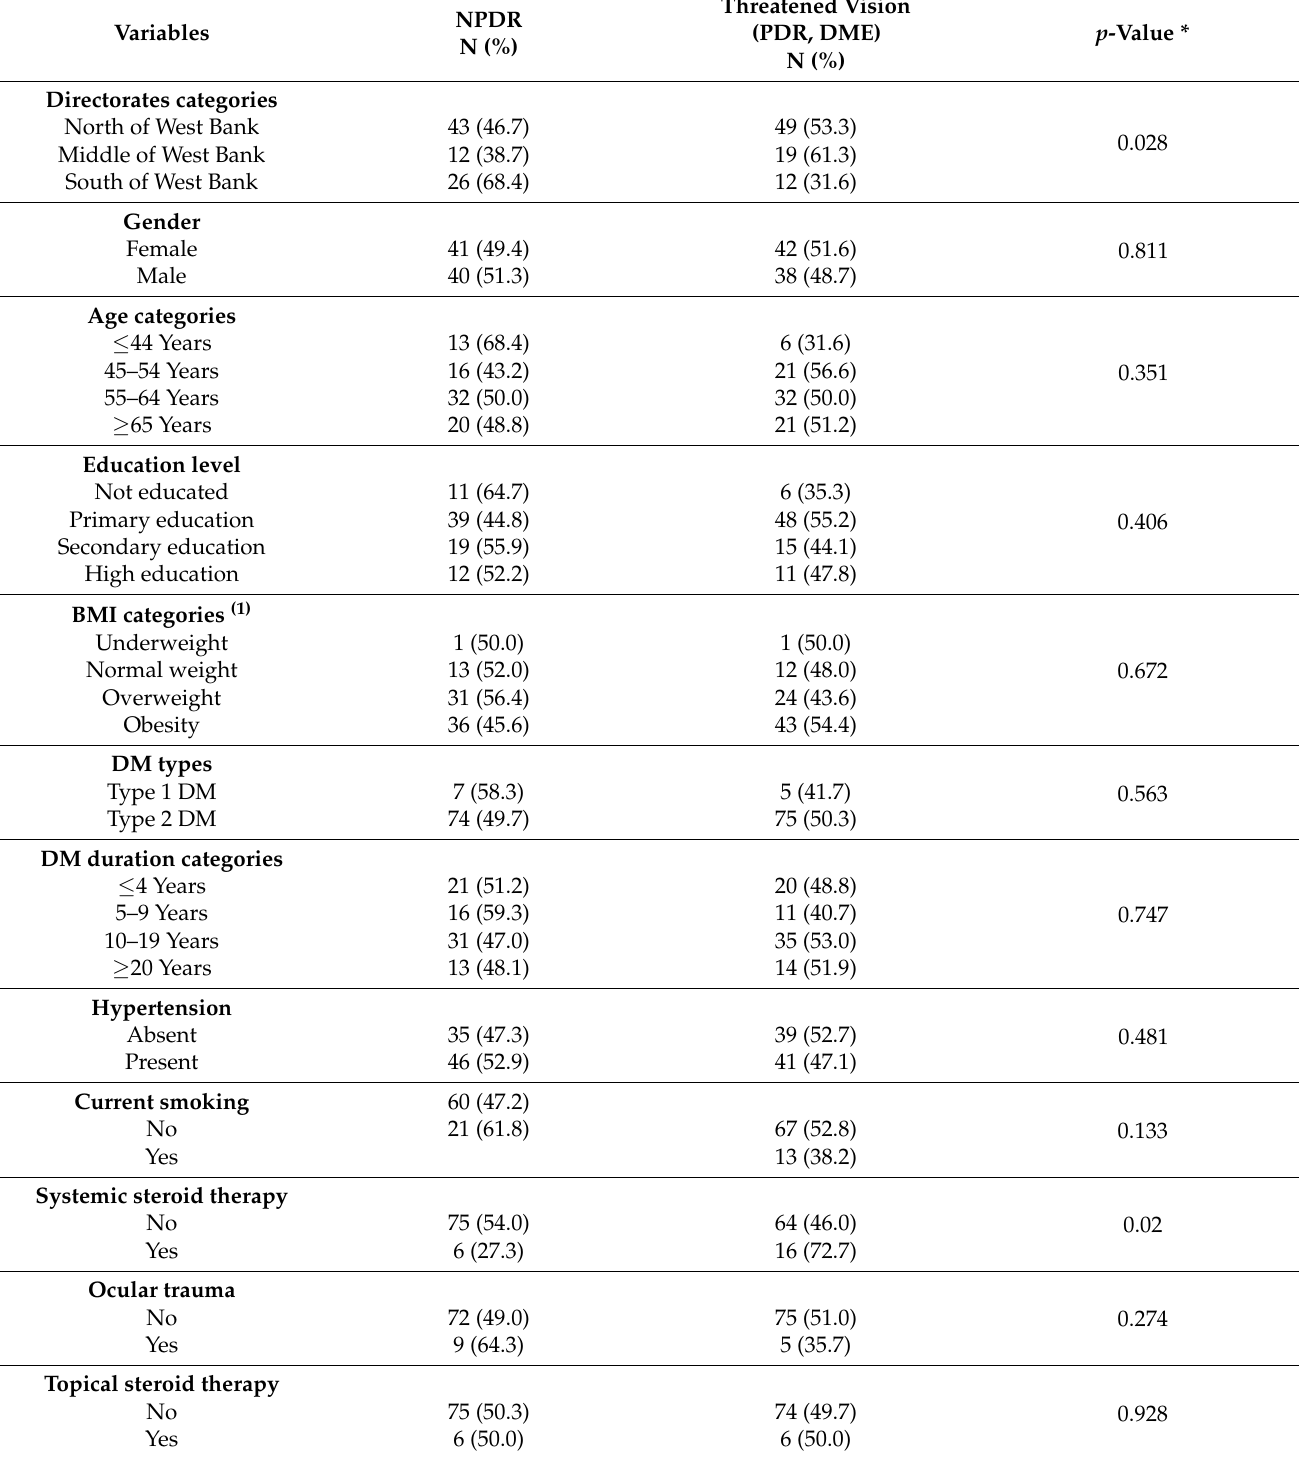
Table 3. Univariate analysis for Non-proliferative diabetic retinopathy (NPDR) and threatened vision (Proliferative diabetic retinopathy; PDR, diabetic macular edema;